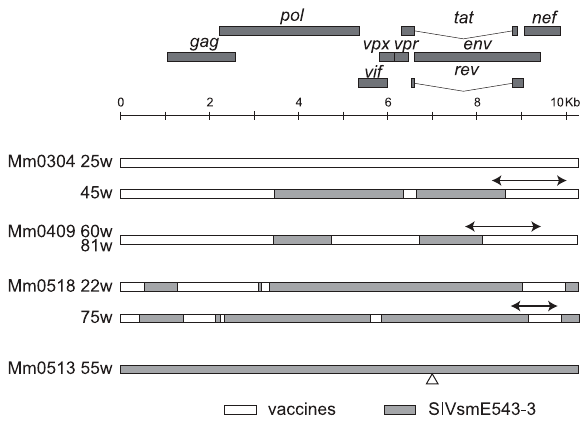
Figure 7. Recombination between vaccine and challenge virus. Nucleotide sequences of SIV fragments amplified by sets of nested PCR using primers based on SIVsmE543-3 or SIVmac239 to cover the entire SIV genome except the 5 9 and 3 9 terminal sequences ( , 100 bp). Representative sequences from integrated results of multiple sequenc- es of PCR fragments are shown. The sequences detected in Mm0304 at 25 weeks pc were the vaccine virus sequences (top bar indicated by open box) and the sequences detected in Mm0513 at 55 weeks pc were the challenge virus sequences (bottom bar indicated by grey box) except in the case of the latter which contained a 9 bp deletion shown by triangle. Other represented sequences were recombinant viruses between vaccine (open boxes) and SIVsmE543-3 (gray boxes). Lines with arrowheads indicate the sequences that were targeted for nested PCR to quantify the recombinant viruses and SIVsmE543-3 in the non-controllers.